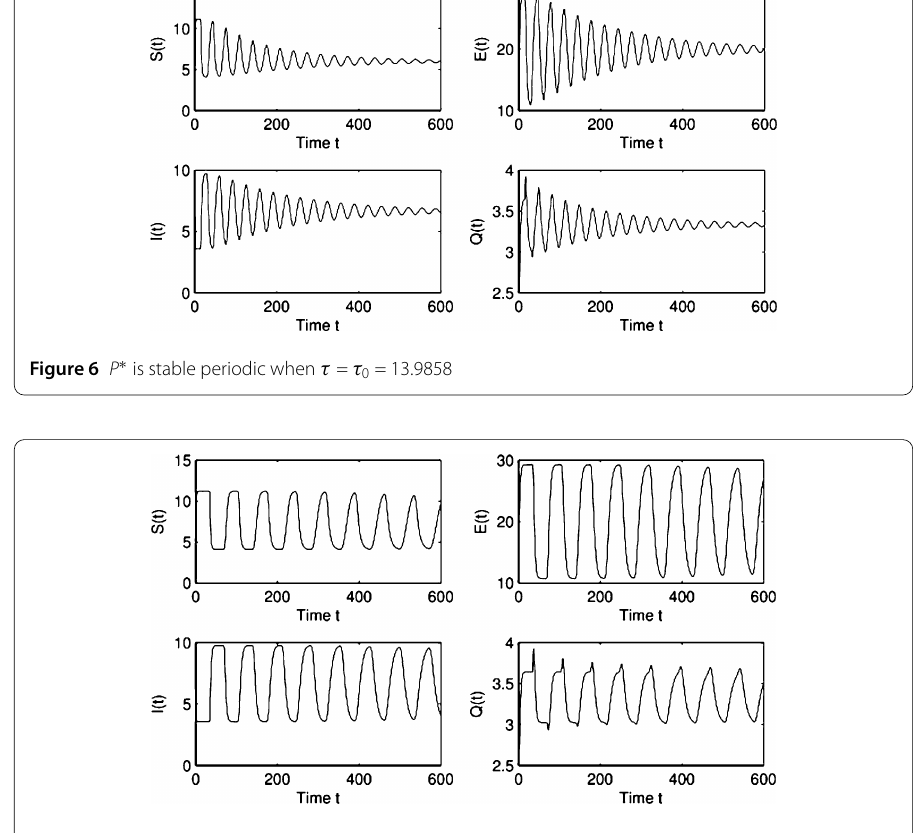
Figure 7 P ∗ loses its stability when τ = 28.85 > τ 0 =